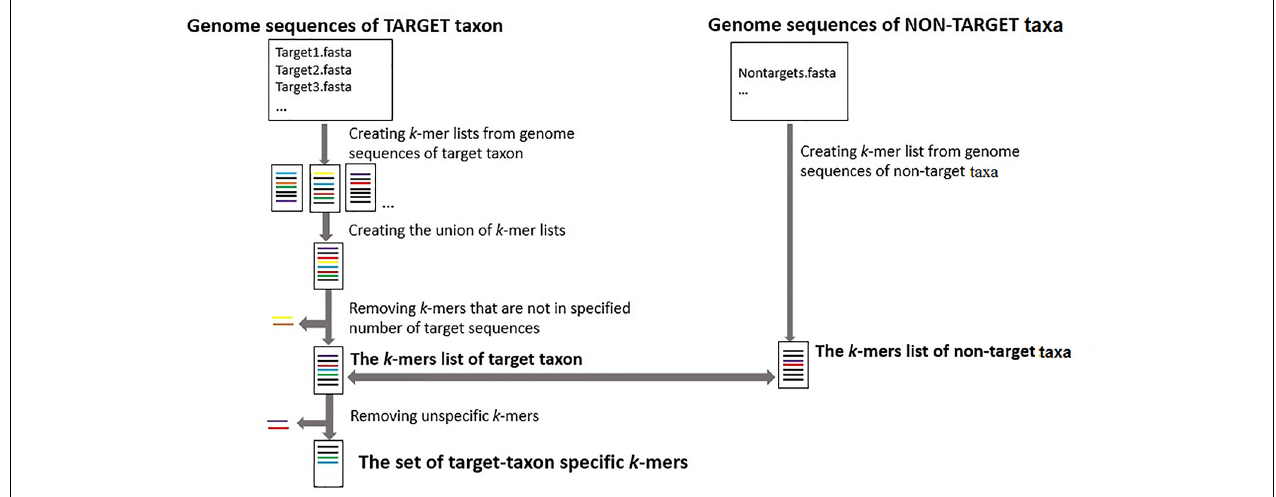
FIGURE 1 | The workflow for identifying taxon-specific k -mers. The process of finding a set of taxon-specific k -mers starts with creating k -mer lists for each sequence of target taxon and all sequences of non-target taxa (from FASTA or FASTQ files). Next the set of k -mers that are not present in a specified number of target sequences or are also present in any non-target sequences are removed to identify the set of taxon-specific k -mers.